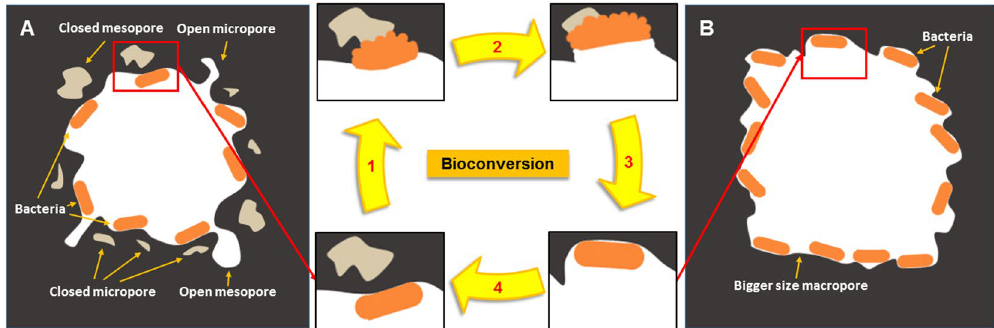
Figure 5. A conceptual mechanism for bioconversion of coal. ( A ) Pore structure before biogenic treatment. There are several isolated and accessible meso-/micropores surrounding the macropore surface where bacteria cannot go into. ( B ) Pore structure after biogenic treatment. Both isolated and accessible meso-/micropores vanished (Fig. 4A,B,C and D) and macropore surface becomes smoother (Table 3). (Note: The cyclic flow chat in the middle shows the process of coal-to-gas bioconversion: 1) Isolated meso-/micropres became accessible; 2) Bacteria continuously consumed the coal matrix near the surface of meso-/micropores; 3) Newly generated accessible meso-/micropres vanished; 4) Another bioconversion cycle